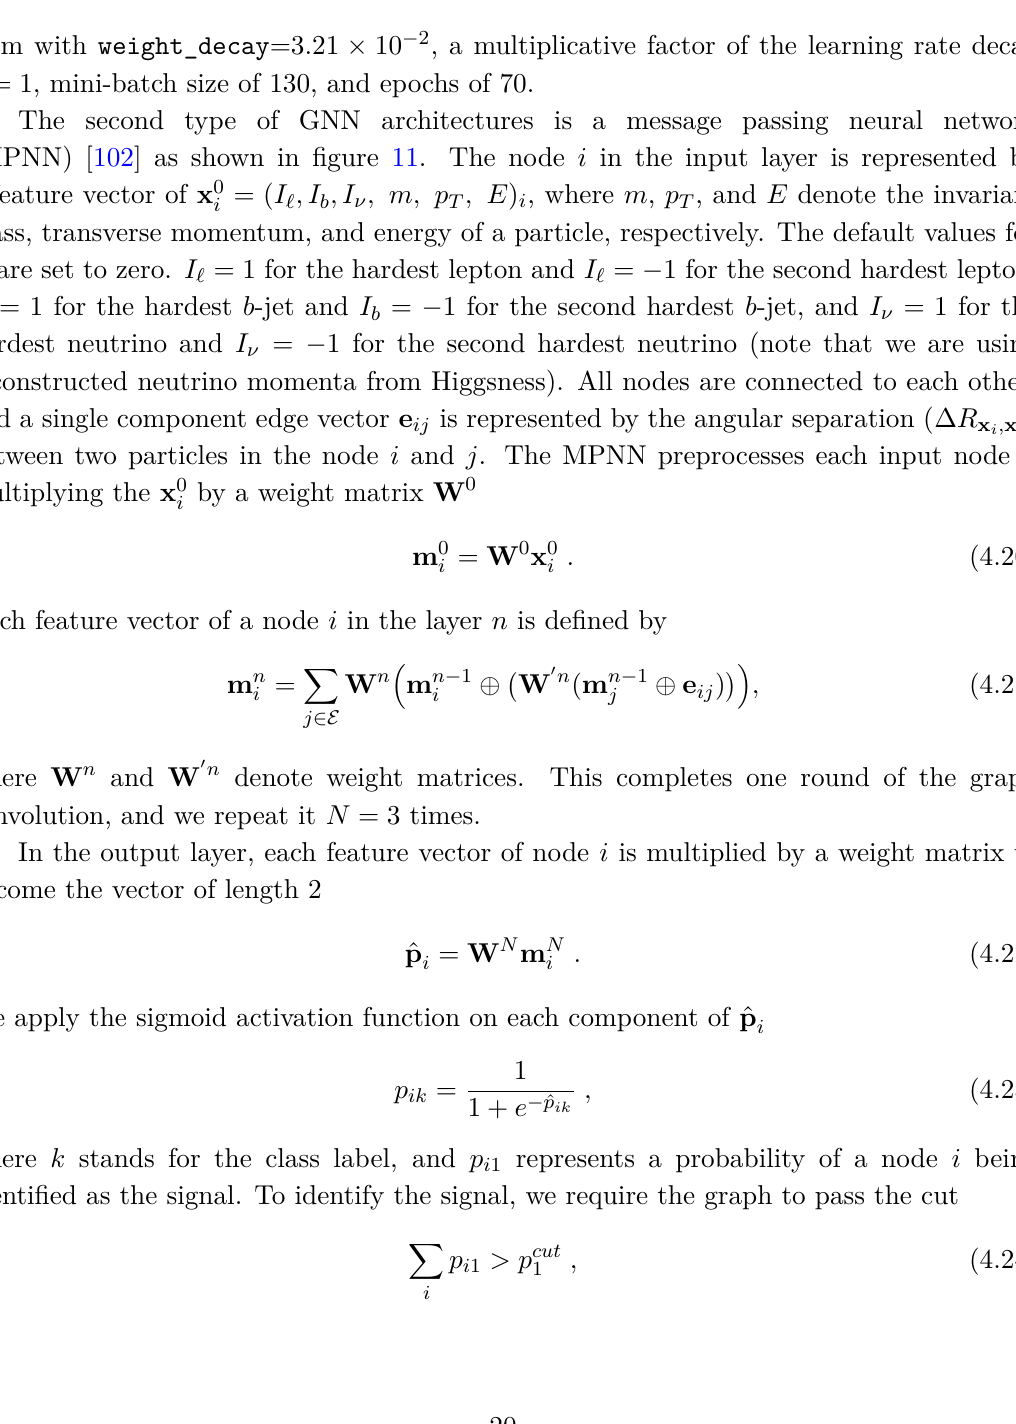
Figure 11 . A schematic architecture of the message passing neural network (MPNN) used in this